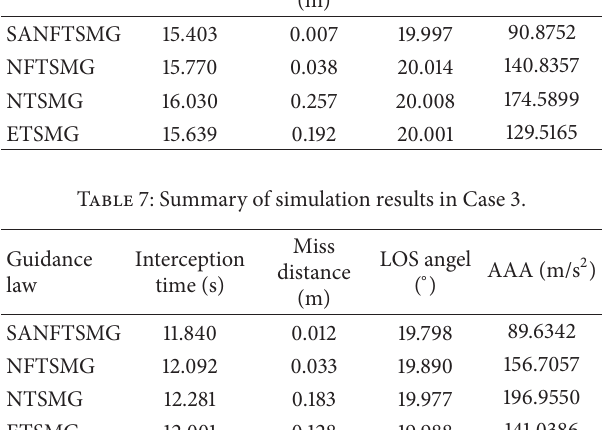
Table 6: Summary of simulation results in Case 2 . Guidance